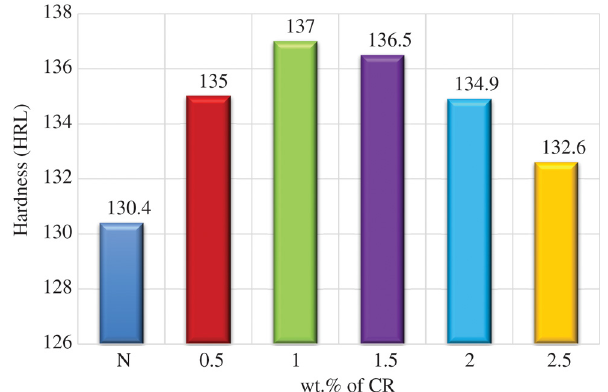
Figure 21: Hardness for various compositions of CFR composite.